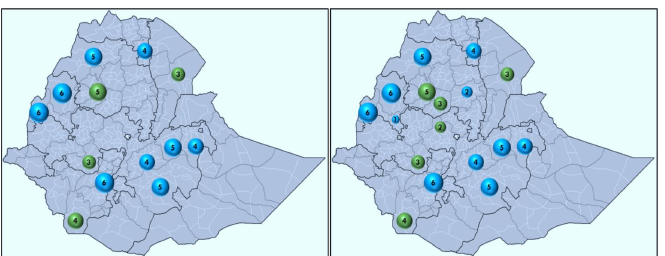
Figure 4. Strategic decisions proposed by Scenario F on locations, technologies and capacities of preprocessing units for the years 2020/2021–2024/2025 ( upper left ), 2025/2026–2029/2030 ( upper right ), 2030/2031–2034/2035 ( lower left ), and 2035/2036–2039/2040 ( lower right